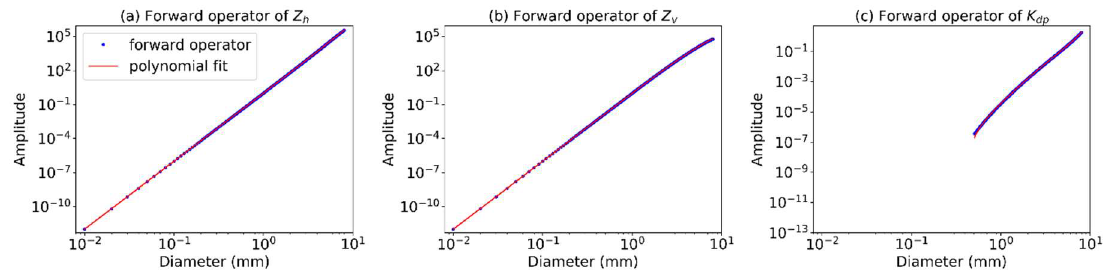
Figure 2. The forward operators and polynomial fit for: ( a ) radar reflectively at the horizontal polarization ( Z h ); ( b ) radar reflectivity at the vertical polarization ( Z v ); and ( c ) specific differential phase ( K dp ).